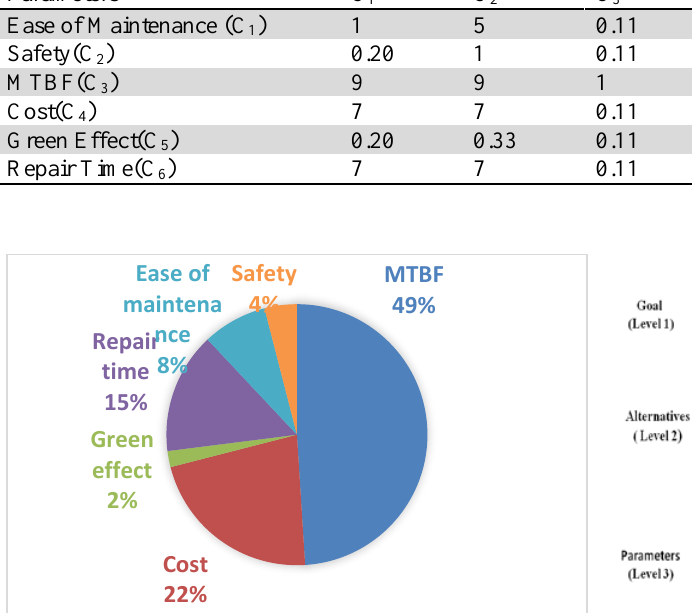
Fig. 3. Contribution of all major parameters towards the selection of capacity waste alternatives in CLG's